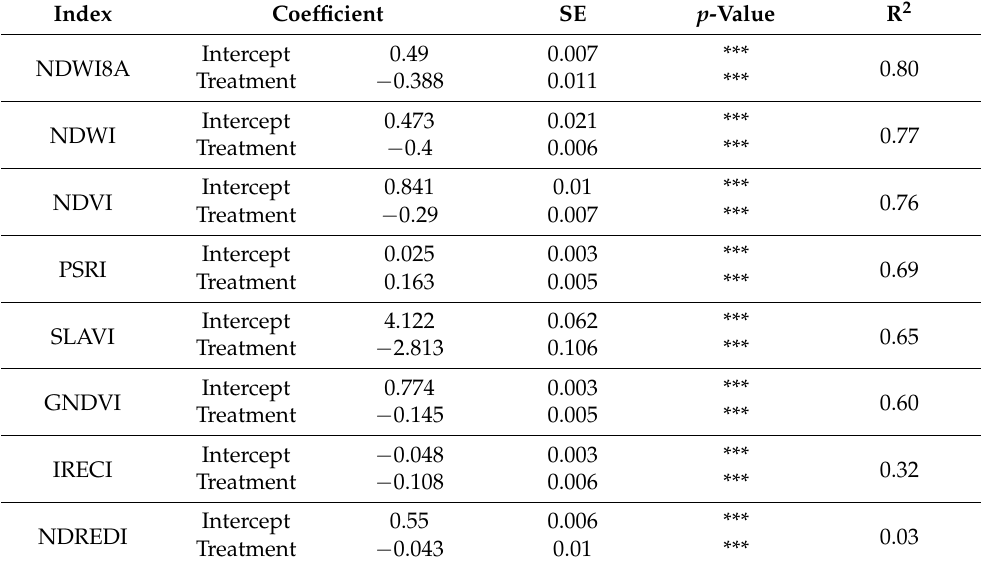
detecting performance (variance